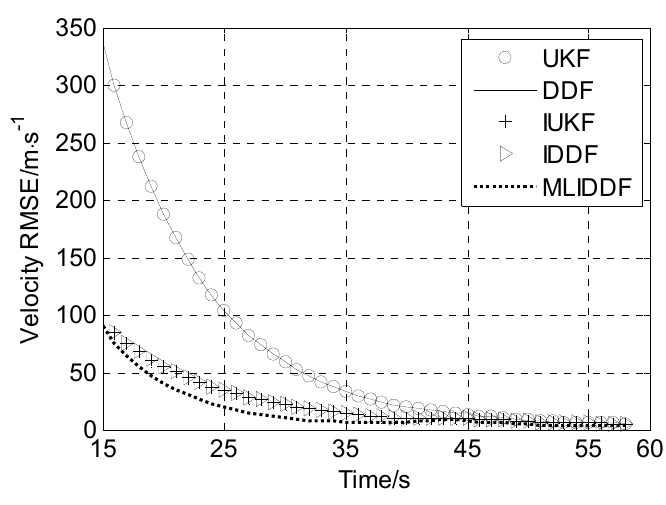
Figure 7. Velocity RMSE s for various filters.